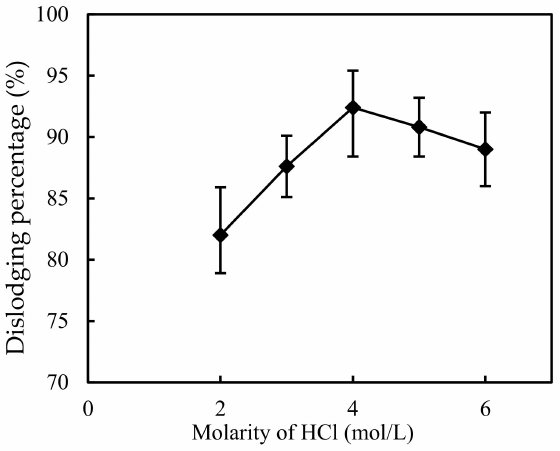
Figure 9. Impact of molarities of hydrochloric acid in the complemental disintegrating stage on dislodging of